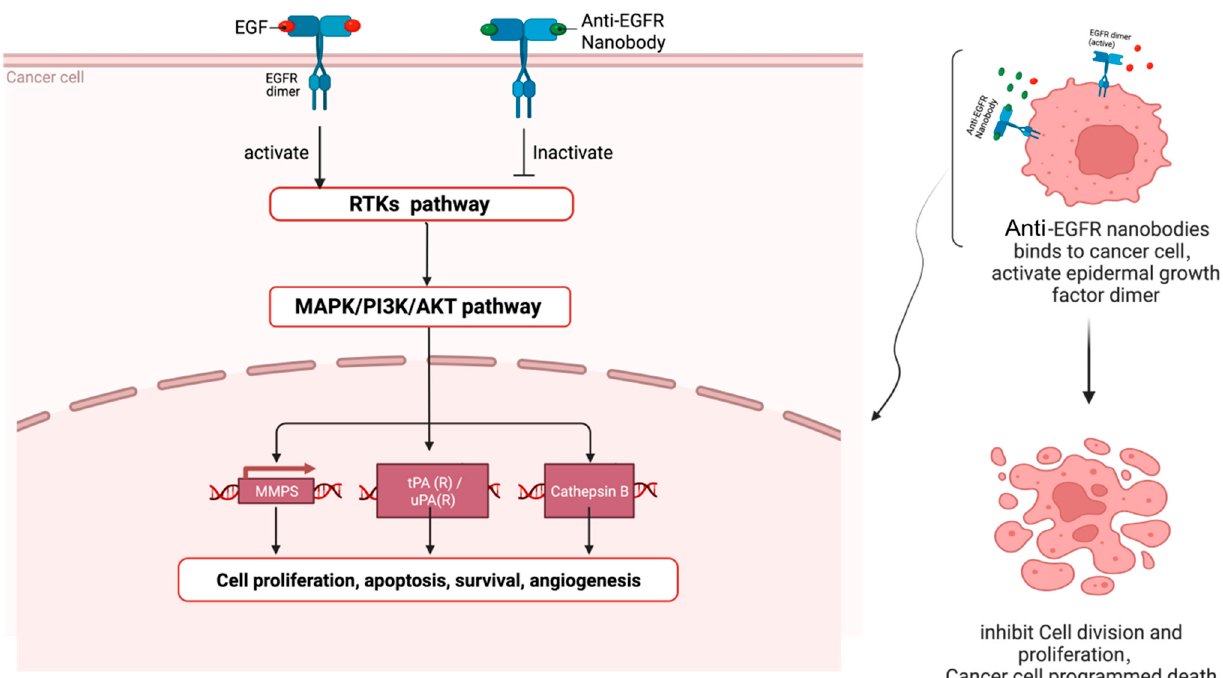
Figure 3. When anti-EGFR nanobodies reach the surface of cancer cells, anti-EGFR nanobodies can compete with EGF to bind EGFR dimers, target cancer cells and inactivate intracellular receptor tyrosine kinase (RTK) signaling pathway, causing cascade reactions of downstream pathways, thereby inhibiting the proliferation of cancer cells (This figure was created with BioRender.com, accessed on 8 August 2022).